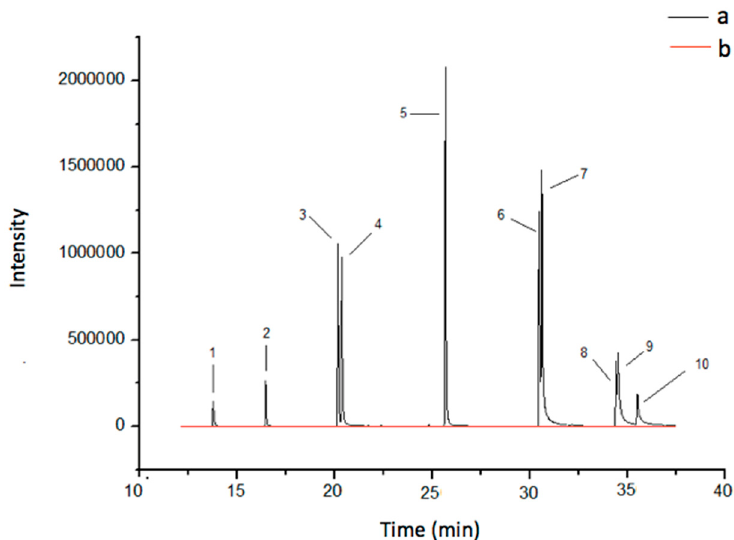
Figure 5. Chromatograms (GC-MS) obtained from a river water sample spiked at 10 µ g L − 1 ( a ) and non-spiked river water sample ( b ). Elution order: (1) acenaphtlylene; (2) fluorene; (3) phananthrene;